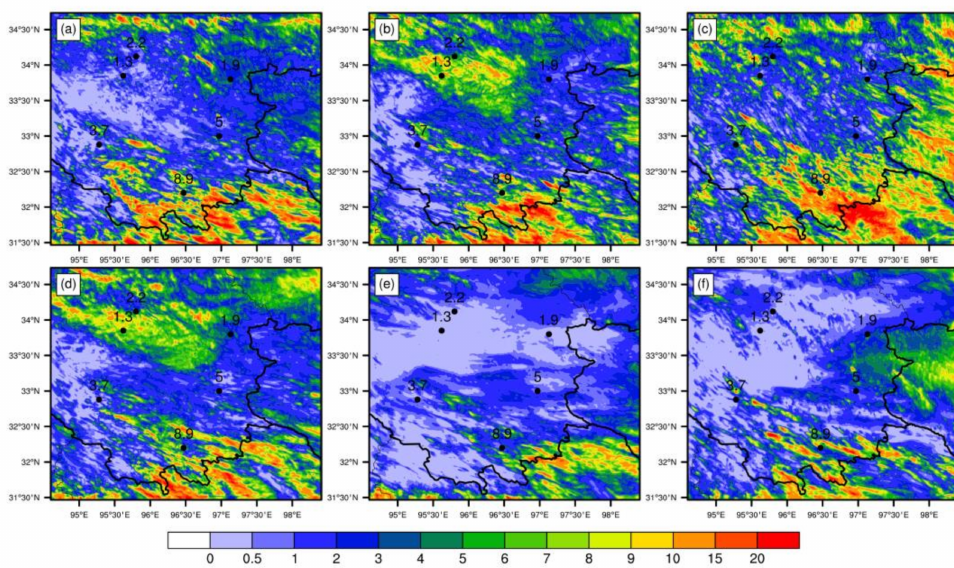
Figure 4. The simulated spatial distribution of the 24h precipitation results from 08:00 on 11 August to 08:00 on 12 August; ( a – f ) show the Lin, WSM5, WSM6, New Thompson, Morrison, and Eta results, respectively (unit: